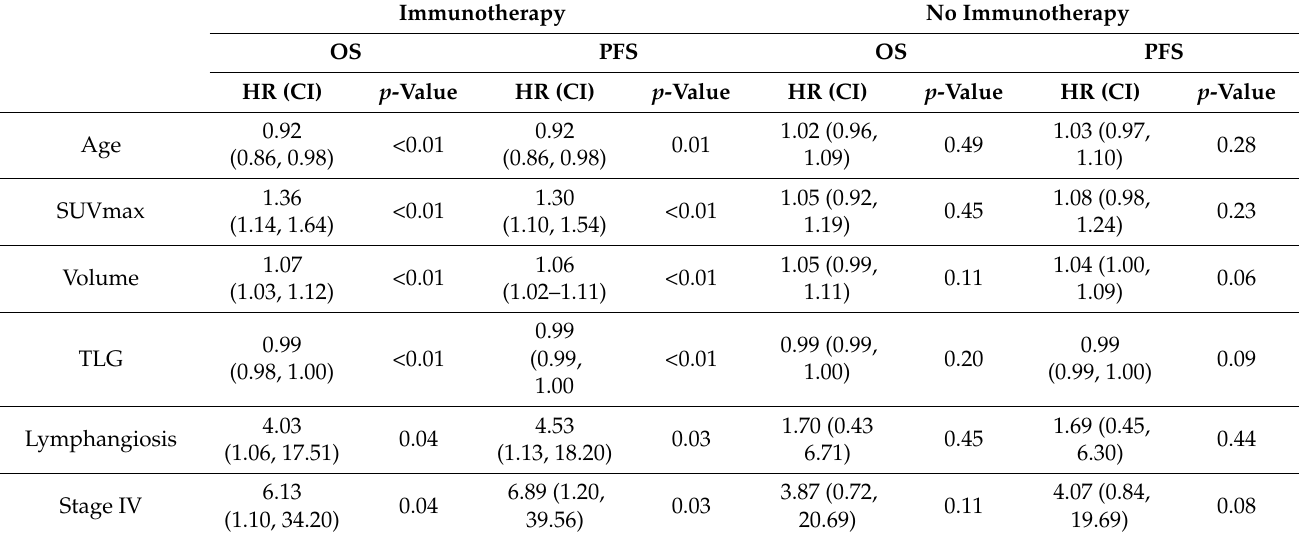
Table 4. The table displays all parameters suggested by the model that predict the lasting response to treatment based on overall survival (OS) and progression-free survival (PFS) in patients treated with immunotherapy vs. no immunotherapy. Each predictor is listed with its hazard ratio, HR, the corresponding 95%-confidence interval, CI, in the brackets below the HR, as much as the significance level right next to HR and CI for each endpoint for the lasting response to treatment, respectively, OS and PFS in patients treated with immunotherapy vs. patients treated with no immunotherapy.